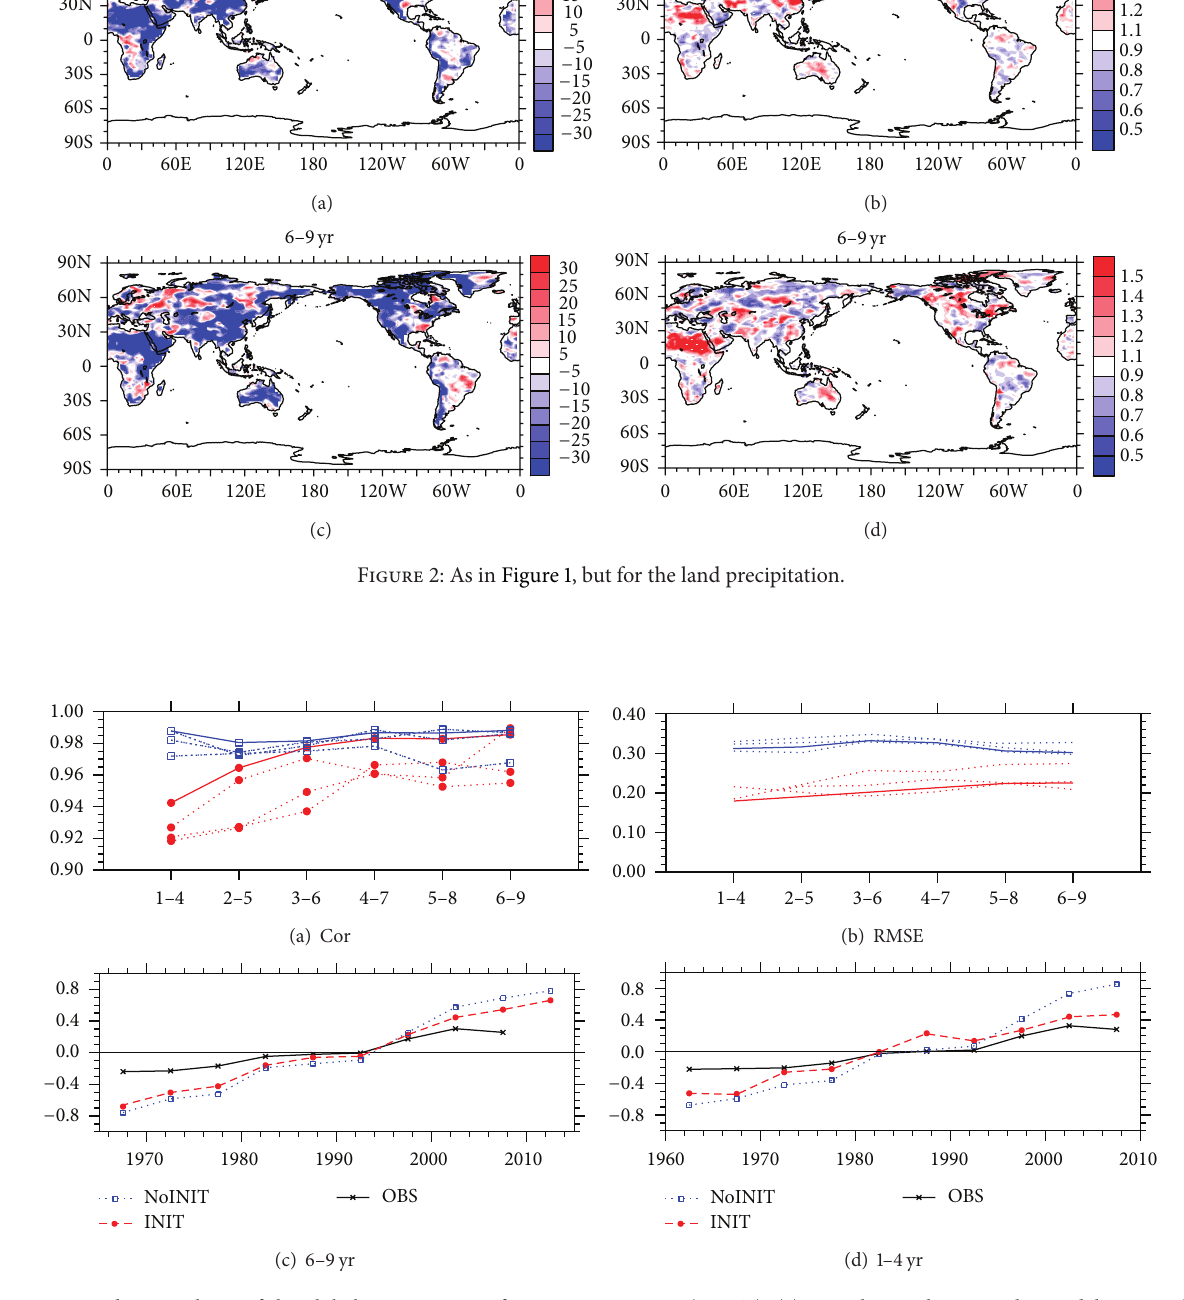
Figure 3: Hindcast qualities of the global mean near-surface air temperature (GMST). (a) Correlations between the model runs and the observational references along the forecast time for 4-year averages. The red (blue) lines denote INIT (NoINIT) runs. The dashed (solid) lines denote ensemble members (means). The dots represent that corresponding correlation coefficients reach the 5% significance level based on one-sided Student’s 𝑡 -test. (b) RMSE of the model runs along the forecast time for 4-year averages. Dots are used when RMSEs of the ensemble mean of the INIT runs are statistically significantly less than those of the ensemble mean of the NoINIT runs at 5% level, based on the one-sided 𝐹 test. (c) Time series of the GMST indices predicted by the ensemble mean of the INIT (NoINIT) runs for predictions averaged over the hindcast years 6–9 and corresponding observational reference (units: K). (d) As in (c) but for hindcast years